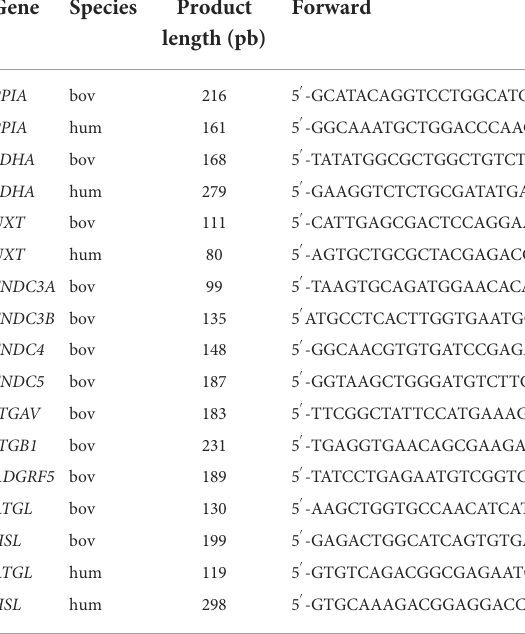
TABLE 3 Nucleotide primer sequences used for real time RT-PCR a . Gene